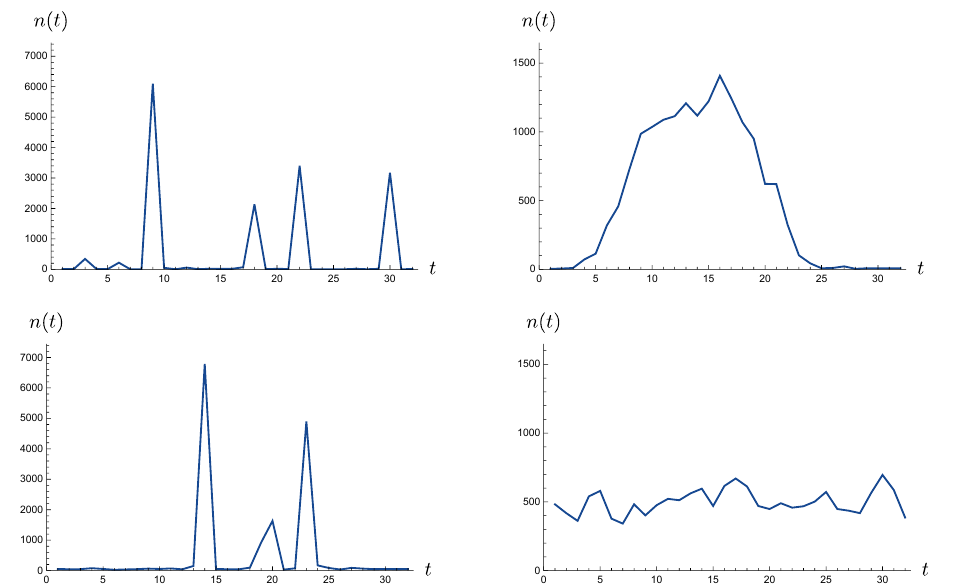
Figure 6. Snapshot volume profiles of geometries in the type III CDT ensemble, with T = 32 time slices and target volume ˜ N 31 = 16000 . The profiles on the left were obtained in the degenerate phase of the system, with k 0 = 8 . 0 . The profiles on the right are taken from the de Sitter phase, with k 0 = 5 . 0 . The top two profiles were taken from the ensemble with spatial genus 0, and the bottom two profiles at spatial genus